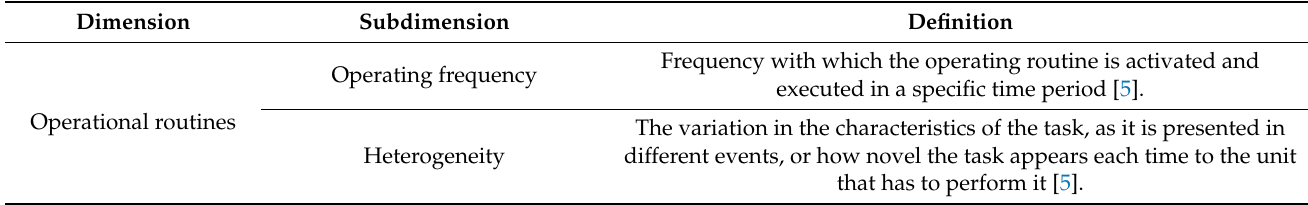
Table 5. Dimension of operational